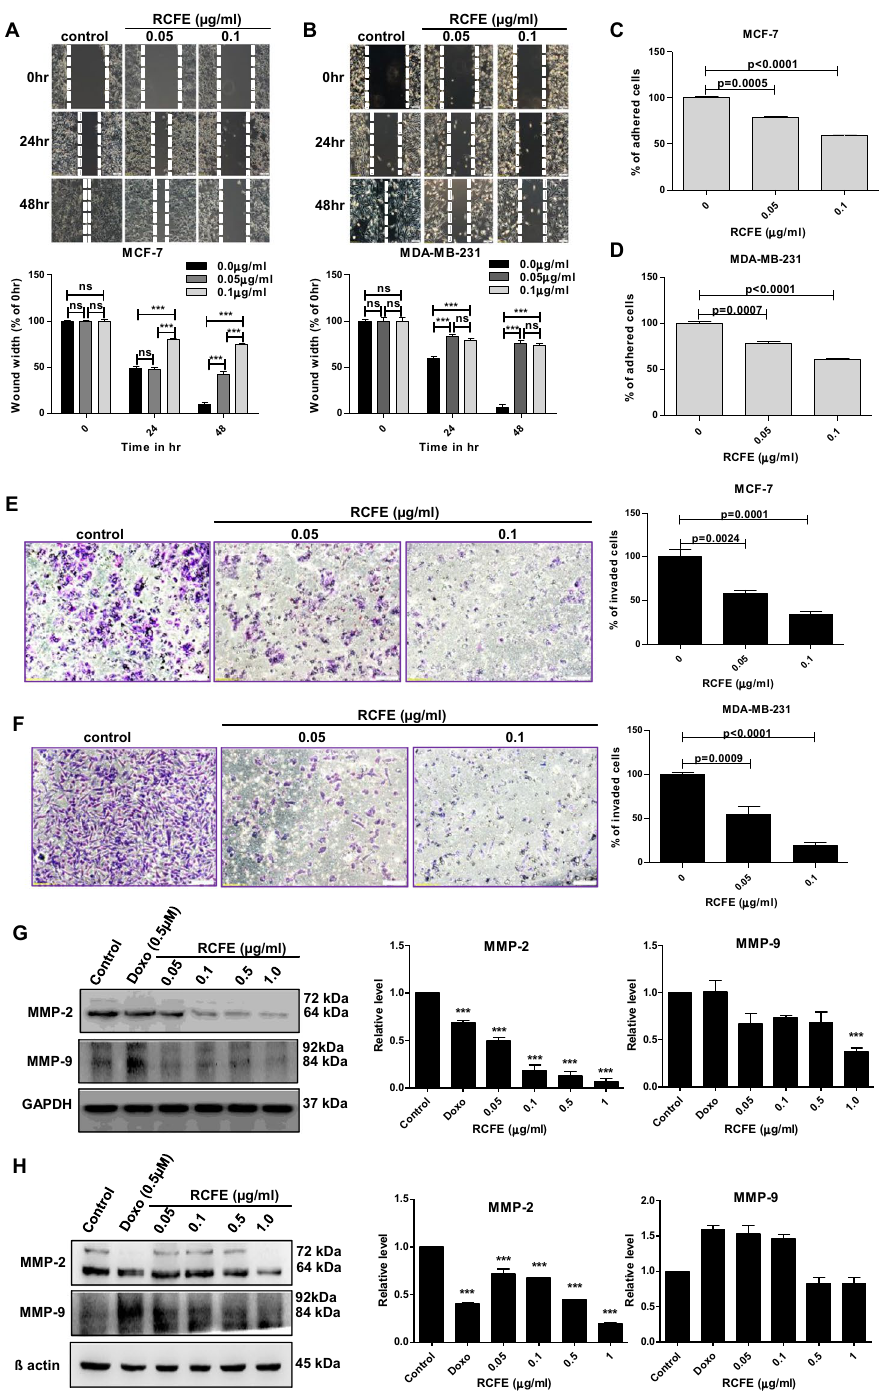
Figure 2. RCFE inhibited metastatic properties of breast cancer cells. Inhibition of migration of MCF-7 ( A ) and MDA-MB-231 ( B ) with treatment of 0.05 and 0.1 µ g/ml for 24 and 48 hr. The quantification of wound widths was shown in right panels. Data represent the mean ± SEM of three independent experiments. Statistical differences were analyzed with two-way ANOVA test. p value ns > 0.05, p value *** < 0.0001. Effect of RCFE on adhesion of MCF-7 (C) and MDA-MB-231 (D) . Data represented as mean ± SEM of three independent experiments. Statistical differences were analyzed with one-way ANOVA test. p value < 0.05 was considered significant. Invasion of MCF-7 (E) and MDA-MB-231 (F) cells through ECM gel coated transwell inserts in response to RCFE. Data represent the mean ± SEM of five different images of individual set of three independent experiments (shown in right panels). Statistical differences were analyzed with student t-test. p value < 0.05 was considered significant. Western blot analysis of MMP-2 and -9 in MCF-7 (G) and MDA-MB-231 (H) cells in response to treatment with RCFE. The quantitation of band intensities was represented in bottom panels. Statistical differences were analyzed with one-way ANOVA test. p value < 0.05 was considered